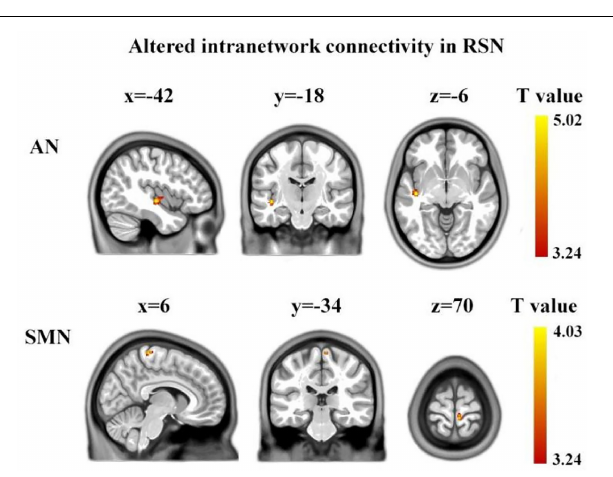
FIGURE 2 | Brain regions showing between-group significant differences in intranetwork functional connectivity. The yellow color denotes the region with significantly increased connectivity in the ASD group, located in AN and SMN, respectively. The color bar represents the T- value (voxel level p < 0.001, cluster level p < 0.05, AlphaSim corrected). AN, auditory network; SMN, sensorimotor